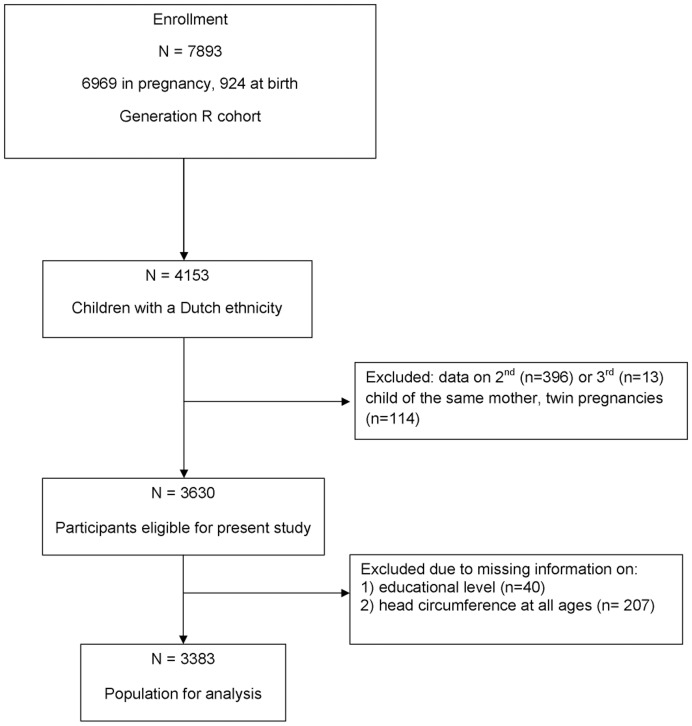
Flowchart of the study population.